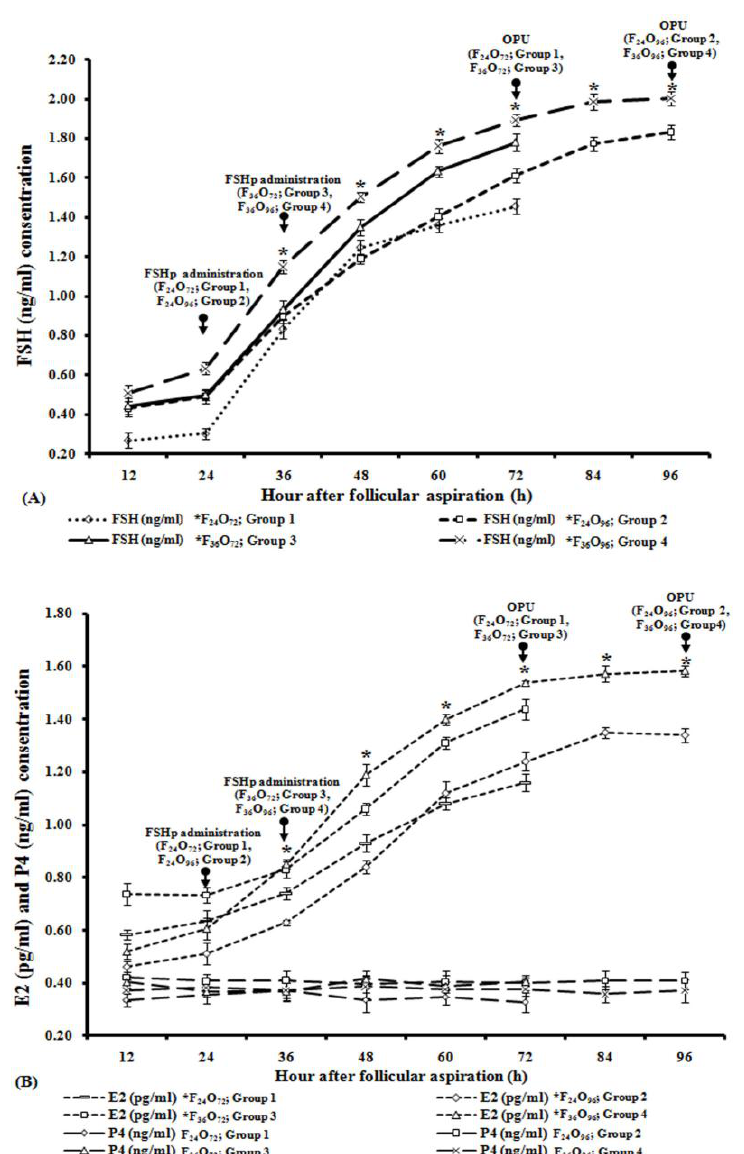
Figure 3. Plasma FSH (Figure 3A), Oestradiol-17  (E2) and Progesterone (P4) (Figure 3B) concentrations after follicular aspiration undergoing repeated superstimulation of ovarian follicular growth and OPU in Thai native heifer. * Protocol code (Group), a single dose i.m. administration of 100 mg FSHp at 24 h and OPU at 72 (F 24 O 72 ; Group 1) or 96 h (F 24 O 96 ; Group 2), and a single dose i.m. administration of 100 mg FSHp at 36 h and OPU at 72 (F 36 O 72 ; Group 3) or 96 h (F 36 O 96 ; Group 4) after follicular ablation. Each dot represents mean  SEM. Values with asterisk (*) indicate significant differences in FSH concentration (Figure 3A) or E2 (Figure 3B) at the time of observation during OPU sessions after follicular aspiration among groups